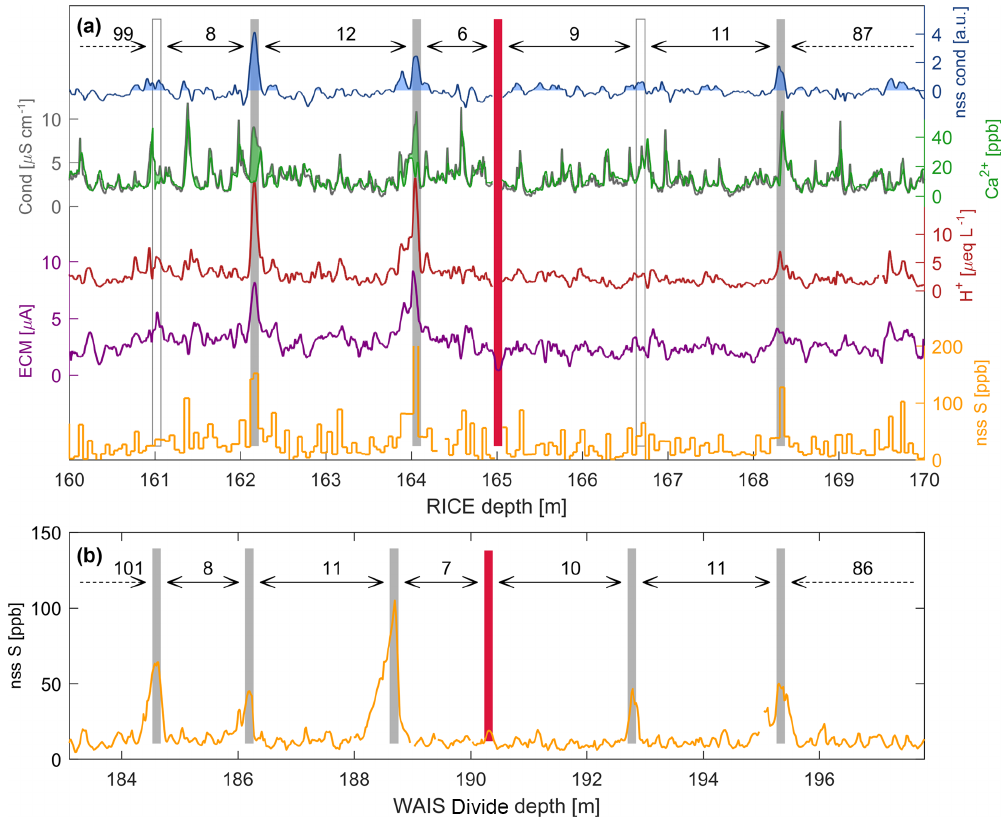
Figure 10. (a) The RICE volcanic proxy records: non-sea-salt sulfur (nss S; orange), ECM (purple), acidity (H + ; red), and non-sea-salt conductivity (nss cond; blue) based on the conductivity-to-calcium (grey, green) excess. Green and blue areas are sections of positive excess. (b) Matching of the RICE records to the WAIS Divide non-sea-salt sulfur record (Sigl et al., 2015). Vertical bars indicate volcanic match points (Table 2), with the number of annual layers between match points in the two records given according to their respective timescales. The red bar represents the Pleiades tephra horizon (1251CE). Two match points (grey bars) had prominent peaks in most of the RICE volcanic records and had an average significance exceeding 2 standard deviations of the general variability of the signal, while the peaks corresponding to two other match points (white bars) were less significant. However, direct comparison of the calcium and conductivity records revealed significant conductivity excess also at these